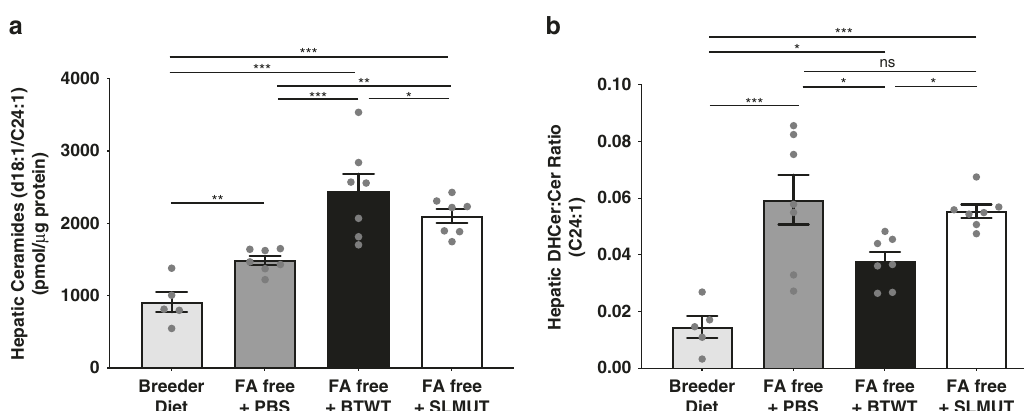
Fig. 4 Oral supplementation of BTWT inhibits hepatic de novo SL synthesis in vivo. a Hepatic ceramides in mice on a breeder diet or a fatty acid free (FA free) diet that stimulates hepatic de novo SL synthesis. Mice on the FA free diet were gavaged with PBS (control), BTWT, or SLMUT. b Hepatic dihydroceramide (DHCer) to ceramide (Cer) ratios for ceramide (d18:1/24:1). Mean values± SEM are plotted, n = 7 per condition, (one-way ANOVA, Holm-Sidak multiple comparison test, * p ≤ 0.05, ** p < 0.01, *** p < 0.001, ns = not-signi fi cant). Source data are provided as a source data fi le. For all fi gures with bars, height of bar = mean and error bar is SEM.